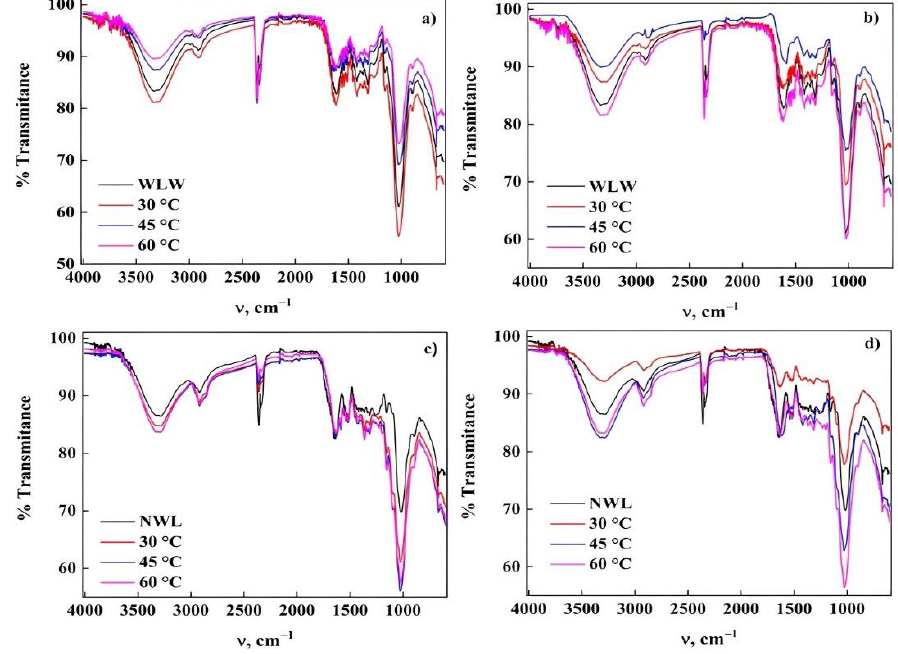
Figure 11. ATR-FTIR spectra of WL after adsorption of dyes: ( a ) WLW-PR; ( b ) WLW-GV; ( c ) NWL-PR and ( d ) NWL-GV .